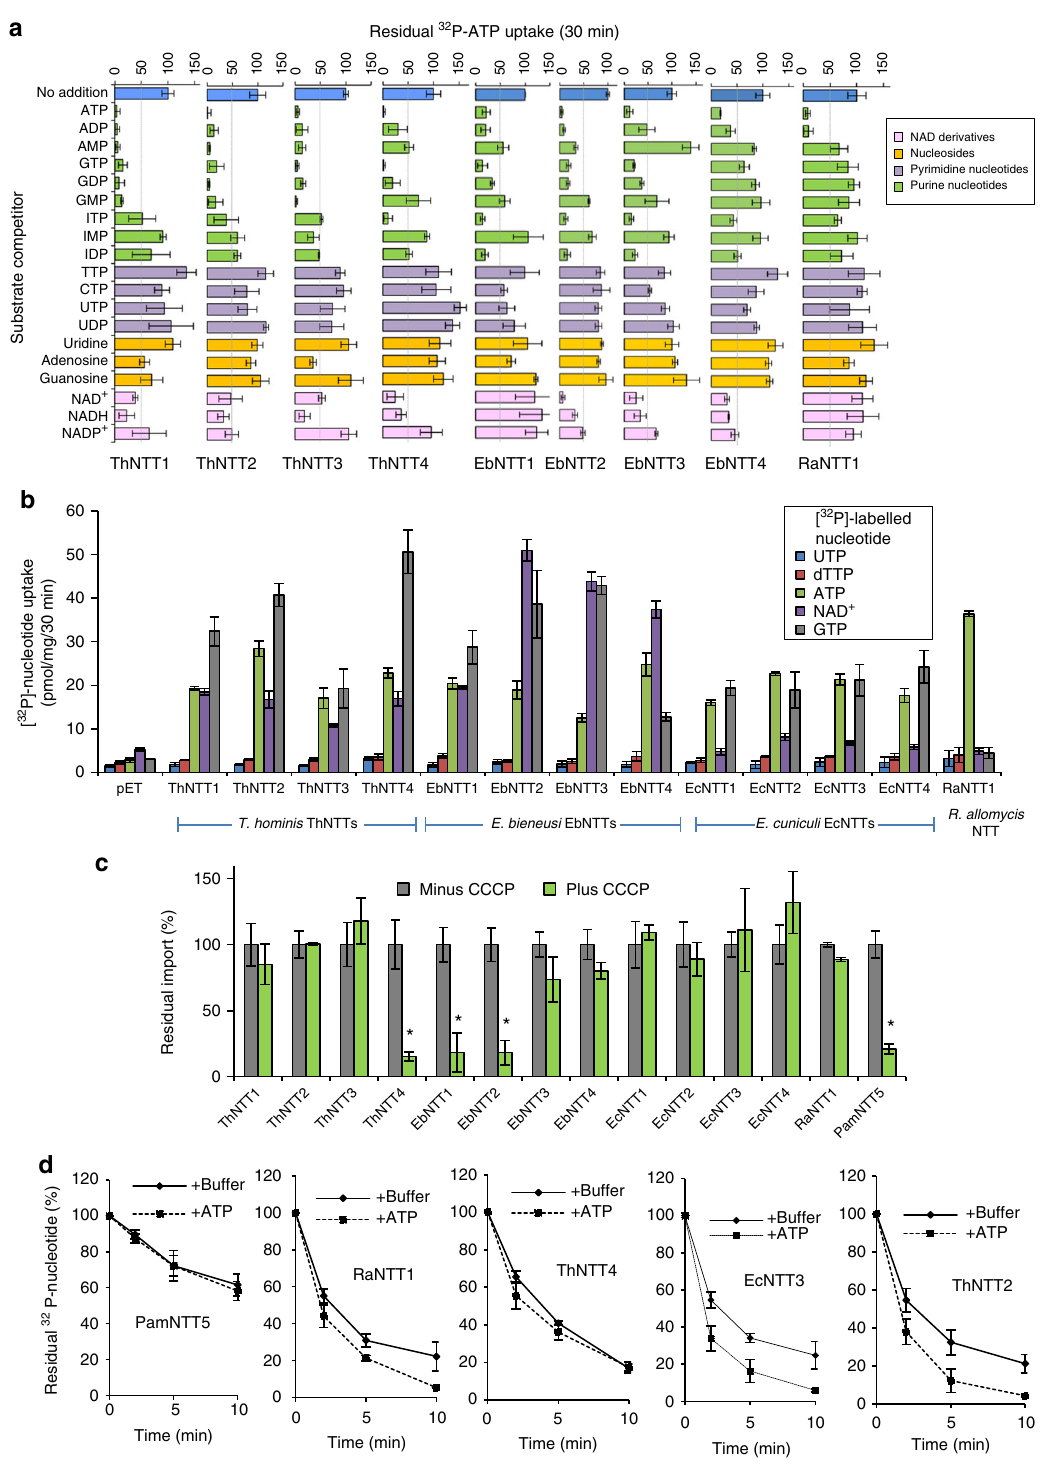
Fig. 3 Substrate competition assays and nucleotide uptake assays for Microsporidia and Rozella NTTs. a Substrate competition assays whereby [ 32 P]-ATP uptake by NTT-expressing E. coli was performed in the presence of 50,000 × excess unlabelled substrate. Th T. hominis , Eb E. bieneusi, Ra R. allomycis . b [ 32 P]-nucleotide uptake assays with E. coli cells expressing NTT genes. Uptake of NAD + by E. cuniculi NTTs was not signi fi cantly different to empty vector controls ( p > 0.05, one-way ANOVA). Coloured bars show transport data for the indicated pyrimidine nucleotides (dTTP or UTP), purine nucleotides (ATP or GTP) or NAD + . pET empty vector control. c [ 32 P]-nucleotide uptake by NTT-expressing E. coli in the absence (set to 100% after control was subtracted) or presence of carbonyl cyanide m-chlorophenyl hydrazone (CCCP). Signi fi cant difference at p < 0.05 (one-way ANOVA) is shown with *. d Back- exchange assay with [ 32 P]-ATP-loaded E. coli incubated in the presence or absence of 100 μ M unlabelled ATP. Data shows the residual radioactivity following washing of the bacteria. PamNTT5 is a positive control symporter from the bacterium Protochlamydia amoebophila 27 . All data (mean ± SD) is representative of at least three independent